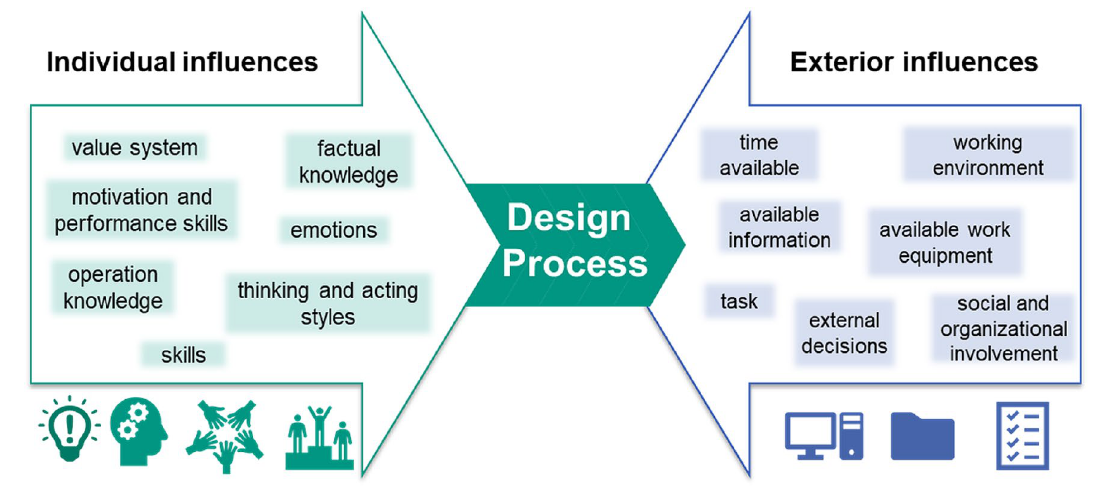
Fig. 4 Influences on the design process according to Dylla